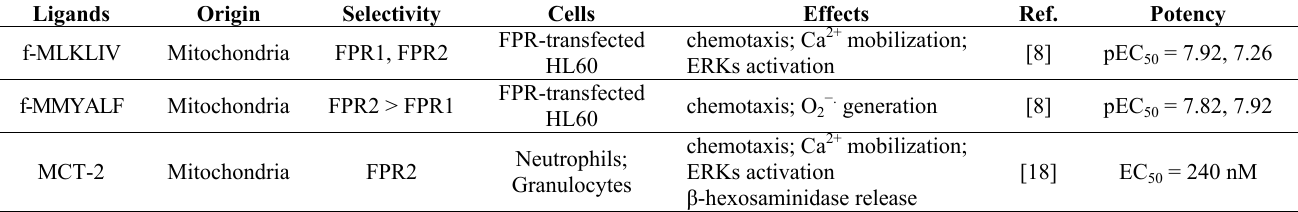
Table 2. Intracellular signaling cascades triggered by mitochondrial